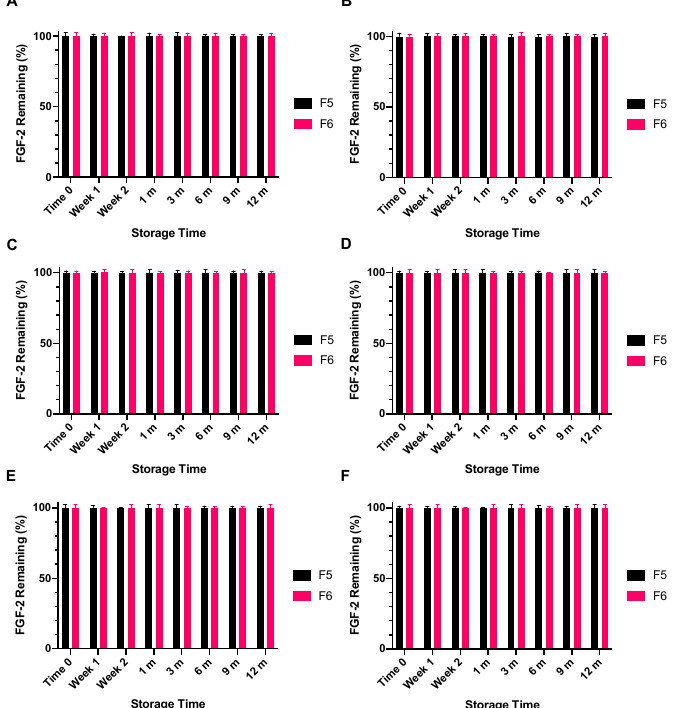
Figure 10. Effect of excipients on the stability of reconstituted FGF-2 aqueous solutions (770 ng/mL) over a 24-h period. FGF-2 in solutions F5 (MC 0.05% w/v and alanine 20 mM) and F6 (MC 0.05% w/v and human serum albumin 1 mg/mL) were lyophilised over 24 h and the dry powders stored at − 4 °C ( A , B ), 4 °C ( C , D ) or 18 °C ( E , F ) for up to 12 months. At defined storage time points, the FGF-2 powders were reconstituted with water, and the resultant solutions were stored for 24 h at 4 °C ( A , C , E ) or 24 h at 18 °C ( B , D , F ). The FGF-2 content in the stored solutions was determined by ELISA and expressed as a percentage of the baseline FGF-2 content determined in the FGF-2 solutions prior to lyophilisation (mean ± SD, n = 3).